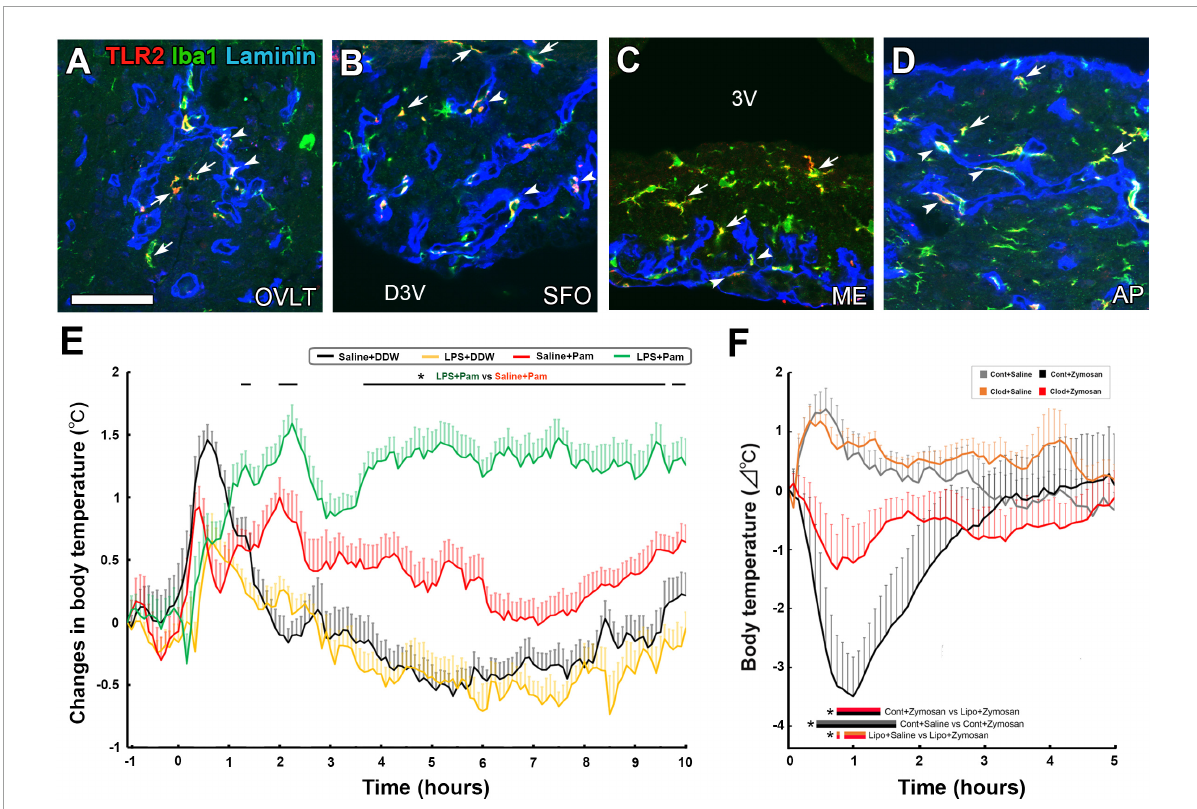
FIGURE3 The expression of TLR2 at microglia and macrophages in the CVOs and TLR2 agonist-induced fever and hypothermia in the adult mouse. Triple labeled immunohistochemistry shows prominent TLR2 expression at Iba1 + microglia (arrows) in parenchyma and Iba1 + macrophages (arrowheads) in laminin + capillary of the CVOs (A–D) . LPS pretreatment promotes fever generation induced by a LMW TLR2 agonist Pam3CSK4 (E) . Depletion of microglia and macrophages with clodronate liposomes attenuates hypothermia induced by the HMW TLR2 agonist zymosan (E) . Scale bar = 50 µ m. 3V, 3rd ventricle; AP, area postrema; D3V, dorsal 3rd ventricle; ME, median eminence; OVLT, organum vasculosum of the lamina terminalis; SFO, subfornical organ; TLR2, toll-like receptor 2. p < 0.05 by an ANOVA with Tukey’s post-hoc test. Photographs are rearranged with permission from Elsevier B.V. [ (A–E) Murayama et al., 2019; (F) Takagi et al.,